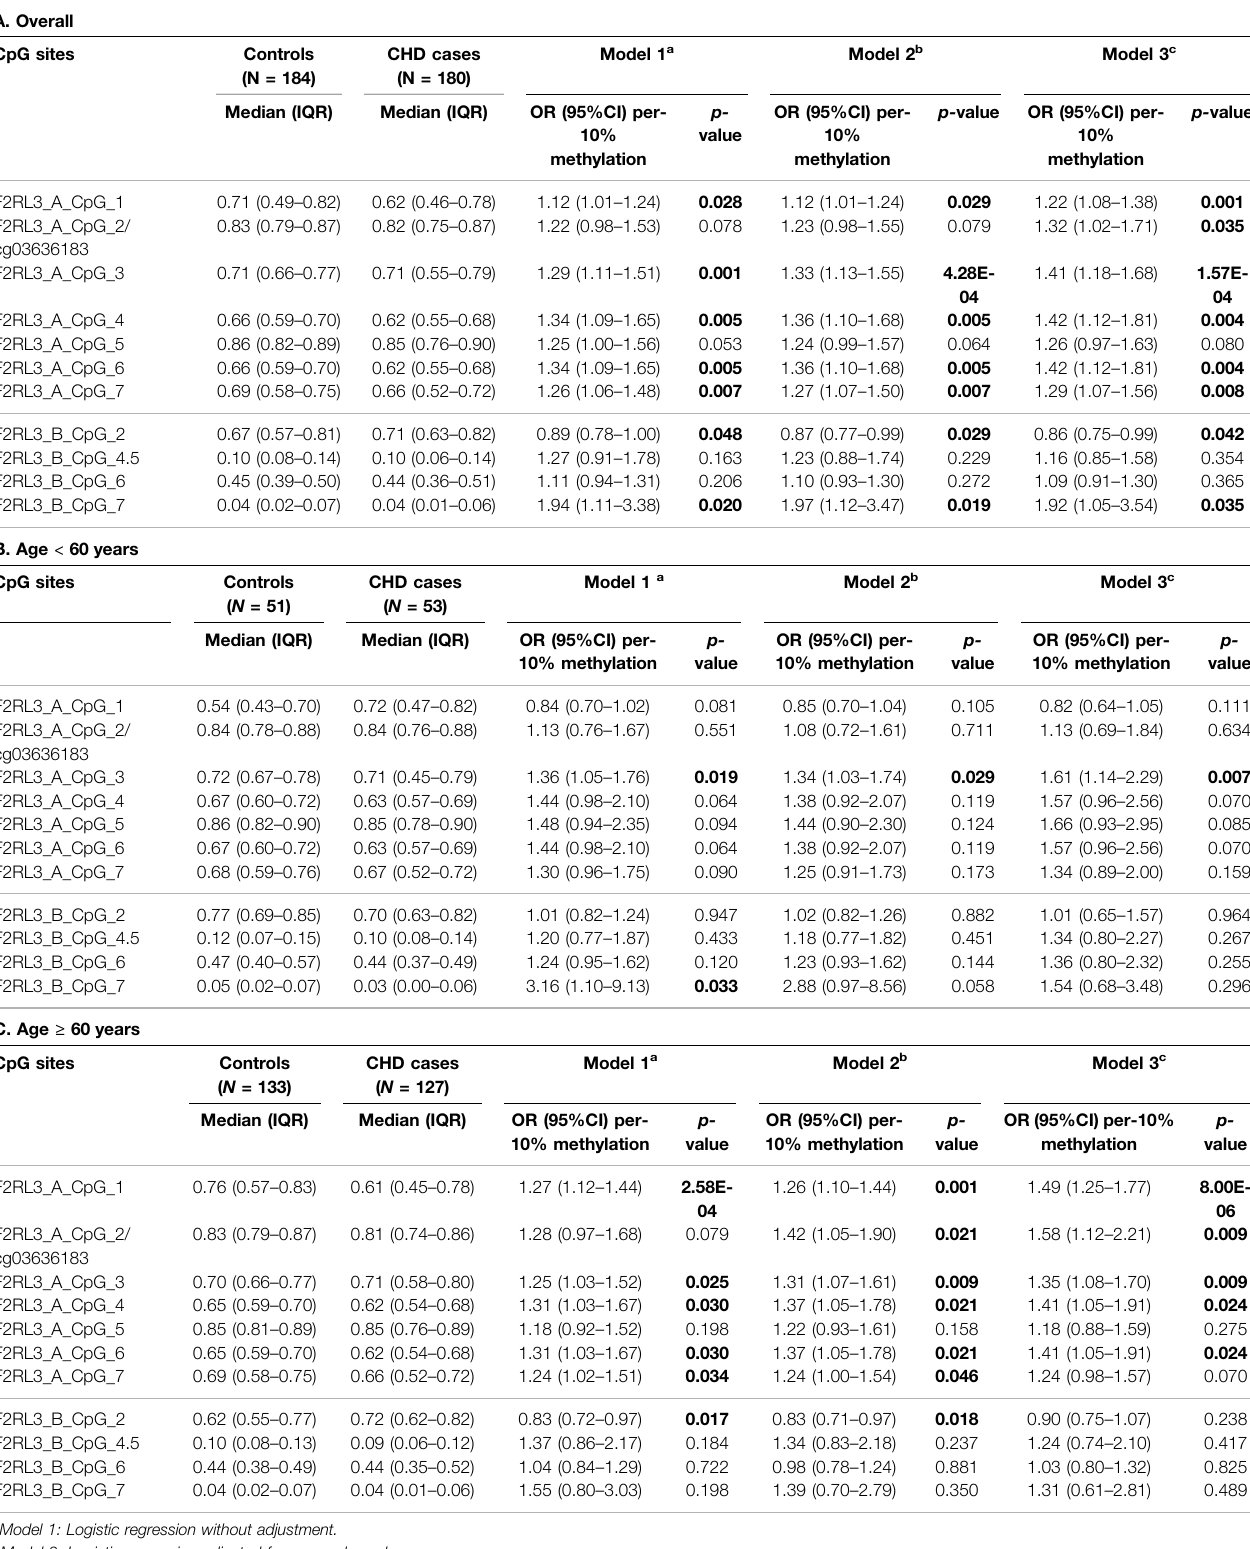
TABLE 2 | Overall and age-speci fi c methylation difference of F2RL3 comparing CHD cases and